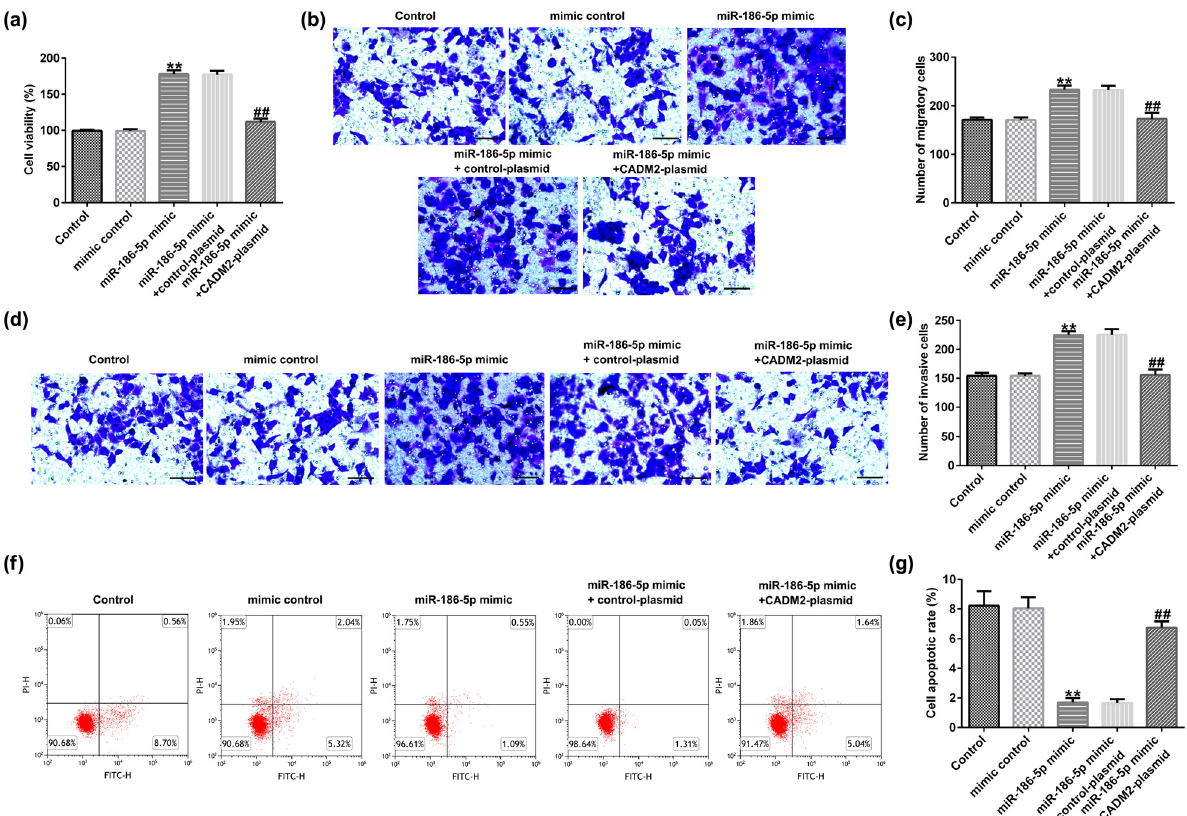
Figure 8: E ff ects of miR - 186 - 5p mimic on the functions of HTR - 8/SVneo cells. ( a ) Viability of HTR - 8/SVneo cells was assessed using MTT assay. Transwell assay was used to analyze HTR - 8/SVneo cell migration ( b ) and invasion ( d ) ( magni fi cation: × 100; bar = 100 μ m ) . The number of migratory cells ( c ) and invasive cells ( e ) was determined. ( f ) Flow cytometry analysis of apoptosis in HTR - 8/SVneo cells. ( g ) Quanti fi cation of apoptotic cells. ** P < 0.01 vs mimic control; ## P < 0.01 vs miR - 186 - 5p mimic + control - plasmid. miR,